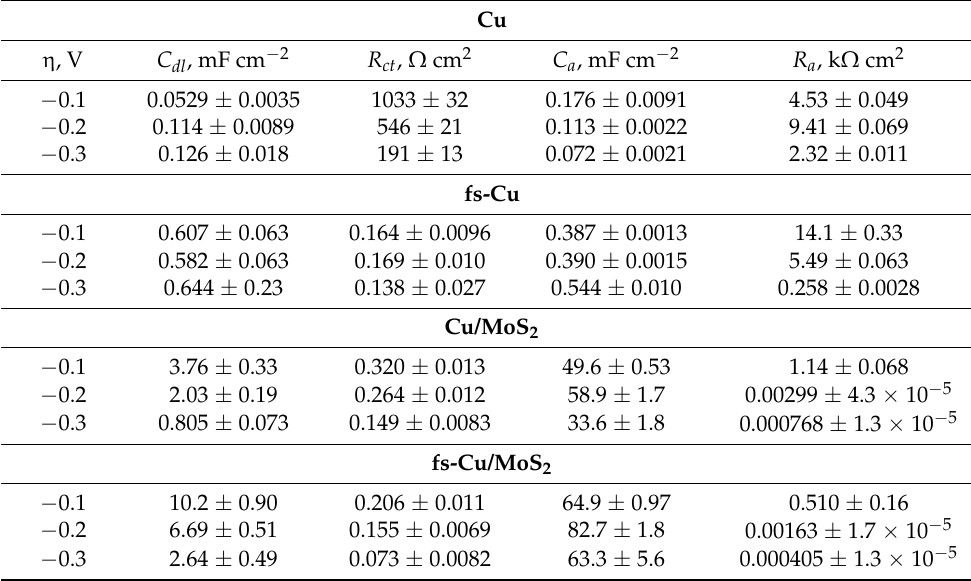
Table 4. The equivalent circuit fitting results and fitting